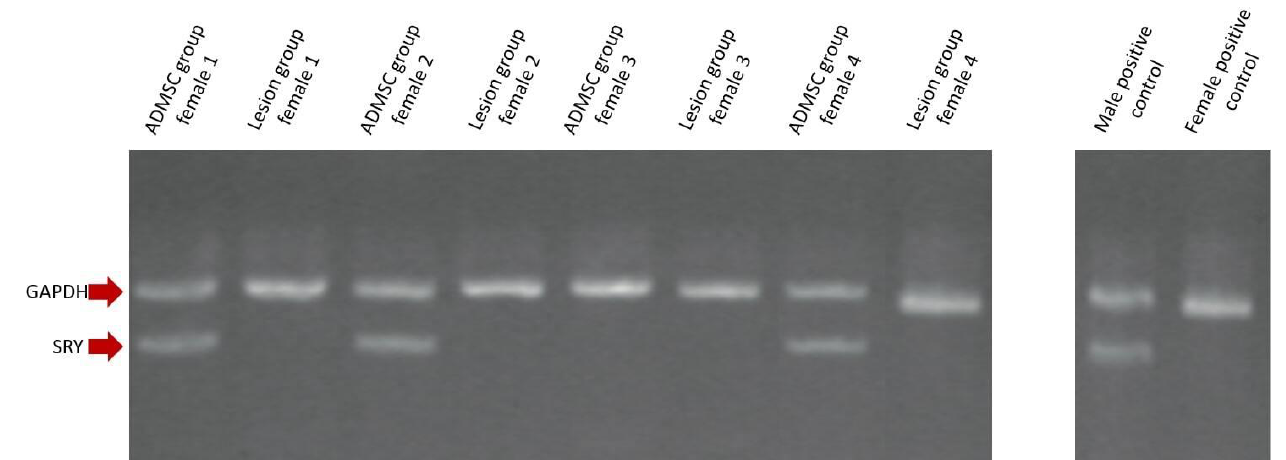
Figure 3. Identification of SRY. The sex-determining region Y (SRY) gene, which has an amplified product of 241 bp was identified in 3 out of 4 female rabbits of the ADMSC group and absent in all the members of the lesion group. GAPDH (287 bp) was used as an internal control and was identified in all members as expected. Male and female controls are also shown. Table 2. Collagen I gene expression.